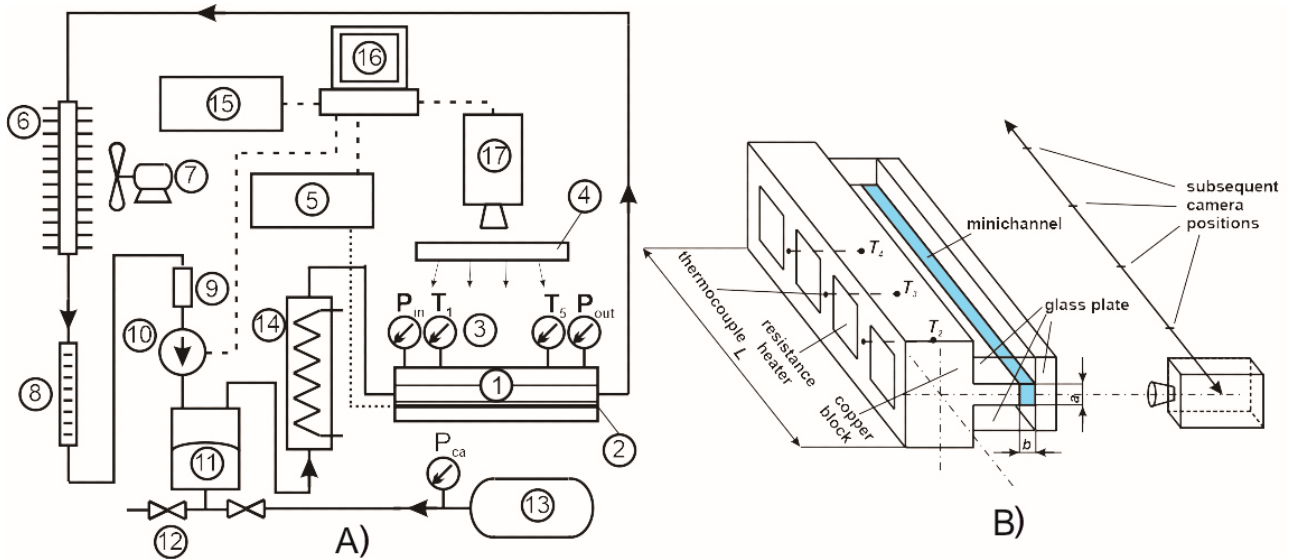
Figure 1. ( a ) Flow loop: 1—measurement module with the mini-channel, 2—heating copper block, 3—temperature and pressure sensors [K-type Czaki, Raszyn, Poland, Kobold Instruments, Pittsburgh, USA], 4—LED lighting, 5—DC power